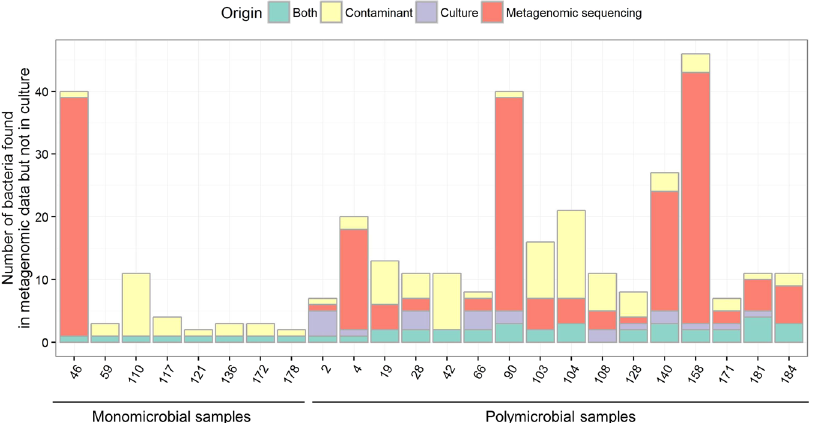
Figure 3. Distribution of the number of species found both in culture and metagenomic sequencing, only in culture and only metagenomic sequencing (in this case, putative pathogenic species and contaminants/ misclassifications are depicted apart). All species identified by MetaPhlAn2 were considered (not only those above 0.1% abundance).